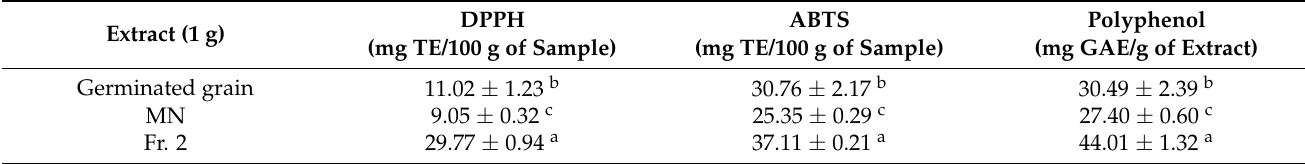
Table 3. Changes in the antioxidant activity of rich fraction extracts.